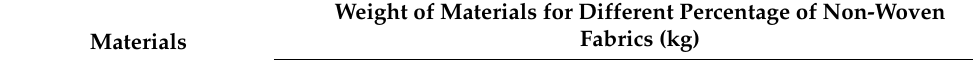
Table 4. Mix designs of concrete with and without cut pieces (kg/m 3 ).